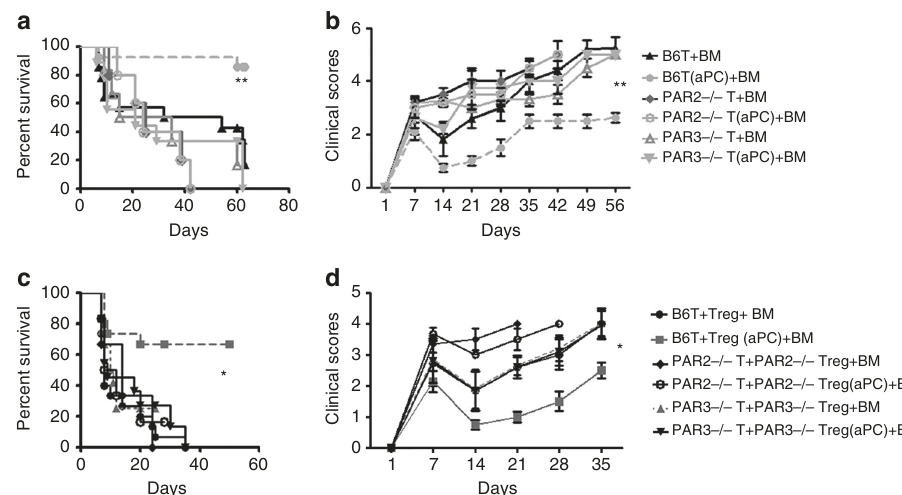
Fig. 8 PAR2-PAR3 cofactoring on T-cells is required for inhibition of GvHD by aPC. a , b Lethally irradiated (11 Gy)-recipient BALB/c mice were transplanted with C57BL/6 wt-derived 5 × 10 6 BM cells and 0.5 × 10 6 T-cells without (B6T + BM) or with (B6T(aPC) + BM) aPC-preincubation (20 nM, 1 h, 37